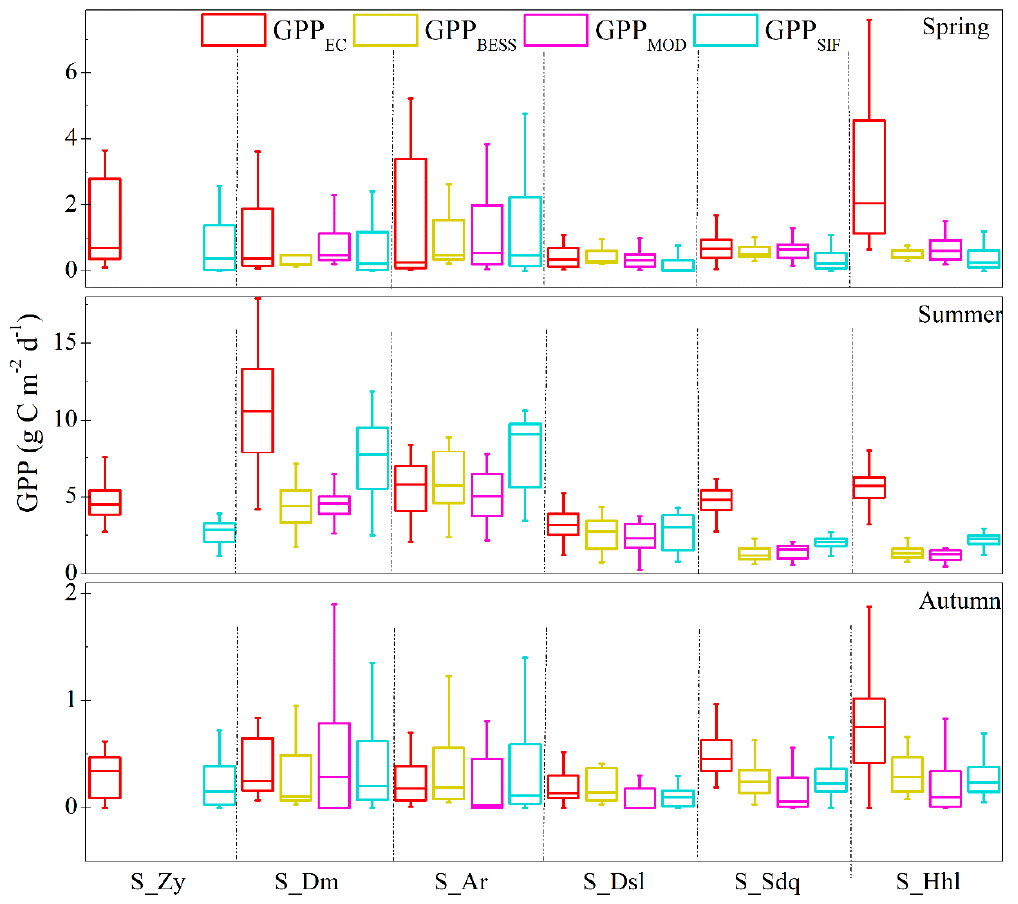
Figure 5. Comparisons of the seasonal patterns of GPP observations (GPP EC ) and the remotely-derived products (GPP BESS , GPP MOD , and GPP SIF ) at the six flux sites during the periods of spring, summer, autumn, and winter, respectively. The box range and whisker range were 25%–75% and 10%–90%, respectively.